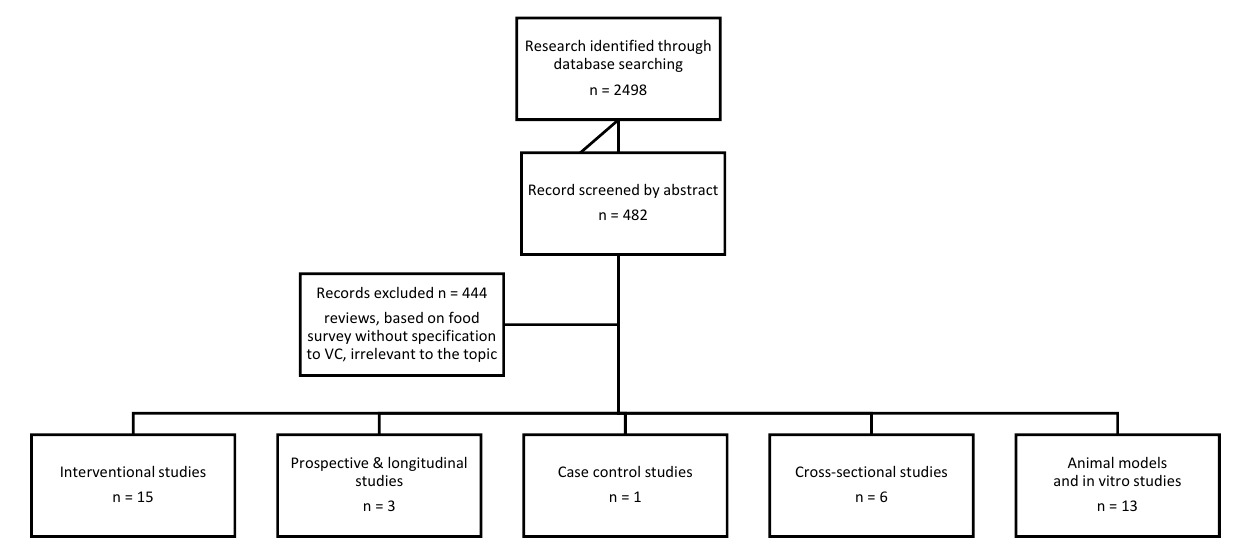
Figure 1. PRISMA (Preferred Reporting Items for Systematic Reviews and Meta-Analyses) flowchart showing the useful study selection process. n : number, VC: vitamin